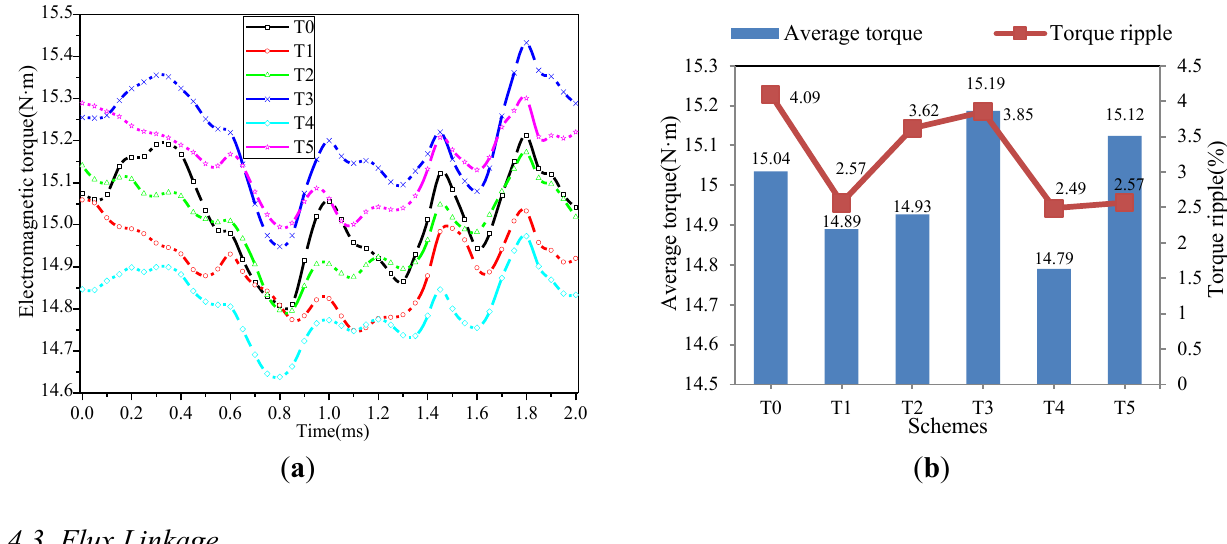
Figure 16. Torque: ( a ) torque at rated speed, 600 rpm; and ( b ) average values and torque ripple.